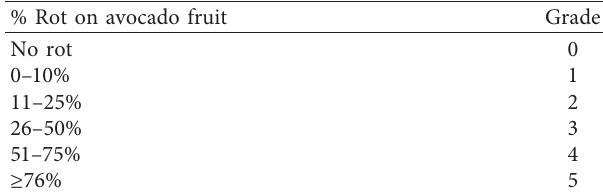
Table 1: Category scale used to rate the severity of SER devel- opment on the avocado